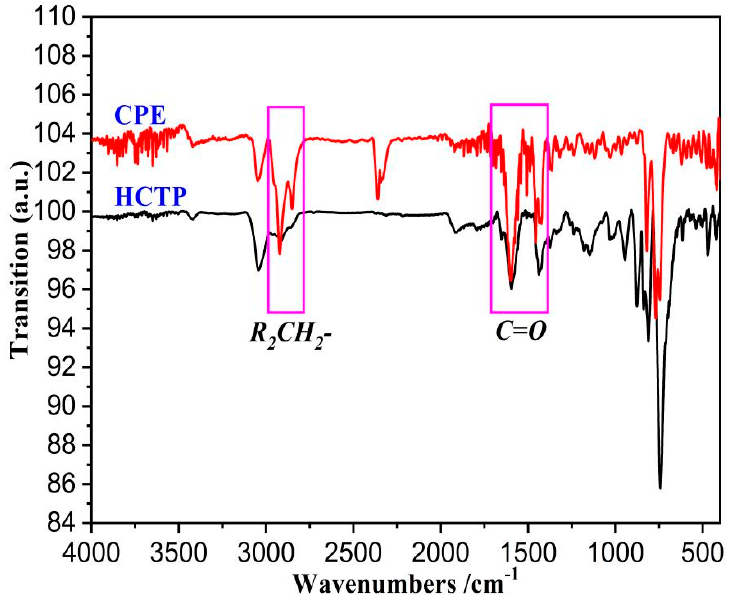
Figure 2. The FTIR spectrum of raw materials.